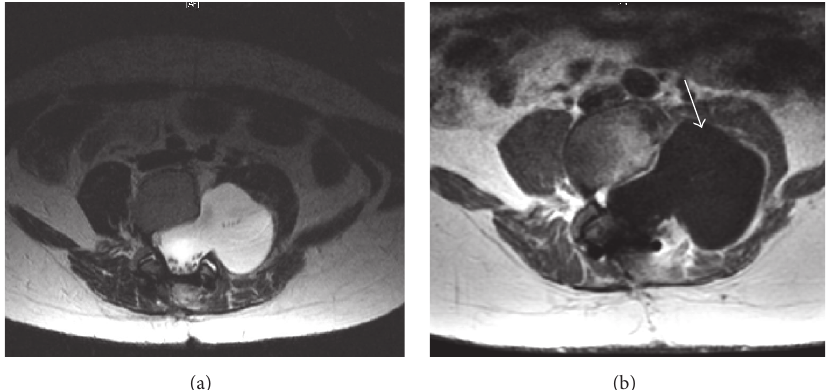
Figure 3: One year after the second operation an axial T2 and T1-weighted postgadolinium MRI images disclosed a pseudomeningocele with roots compression and displacement of the psoas muscle (white arrow).